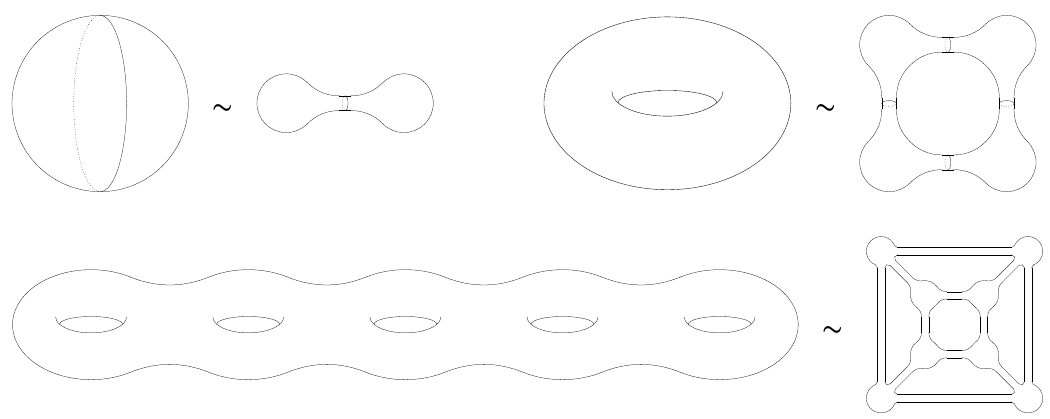
Figure 7: Compact representation of branch cuts for the sheets G (right) of R after adding the points at infinity. The branch cuts are represented as 5 straight lines for clarity, and distances are not meaningful.